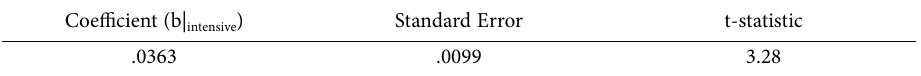
Table 5. Analysis of the evolution over time of posterior probabilities.